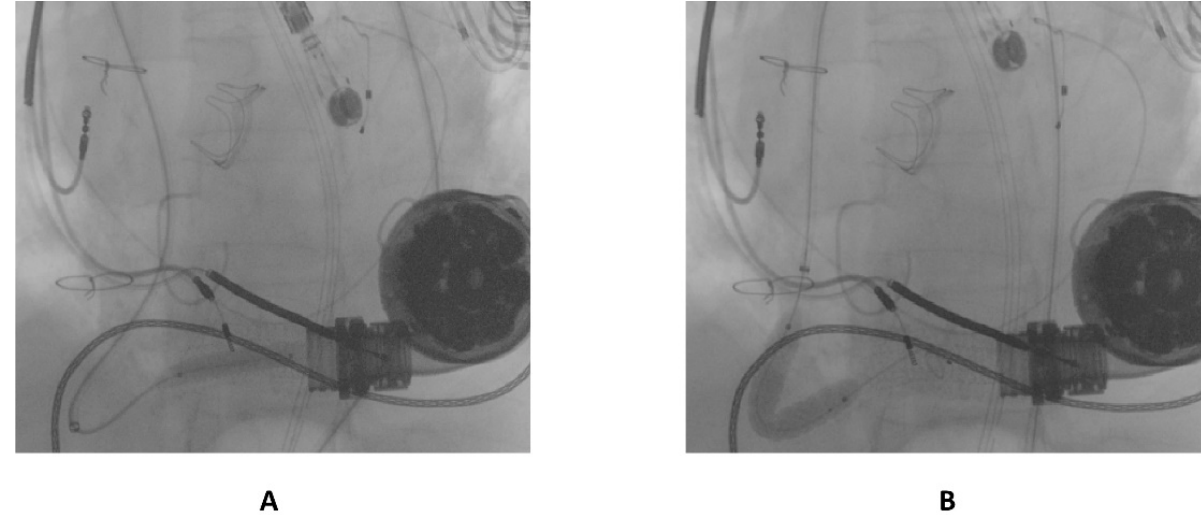
Figure 3. ( A ) distal anchoring; ( B ) stent deployment. Due to severe underexpansion of the implanted stent, several postdilations were performed using peripheral balloons of increasing diameters (MUSTANGTM 0.035 ″ , Boston Scientific) (see Figure 4).